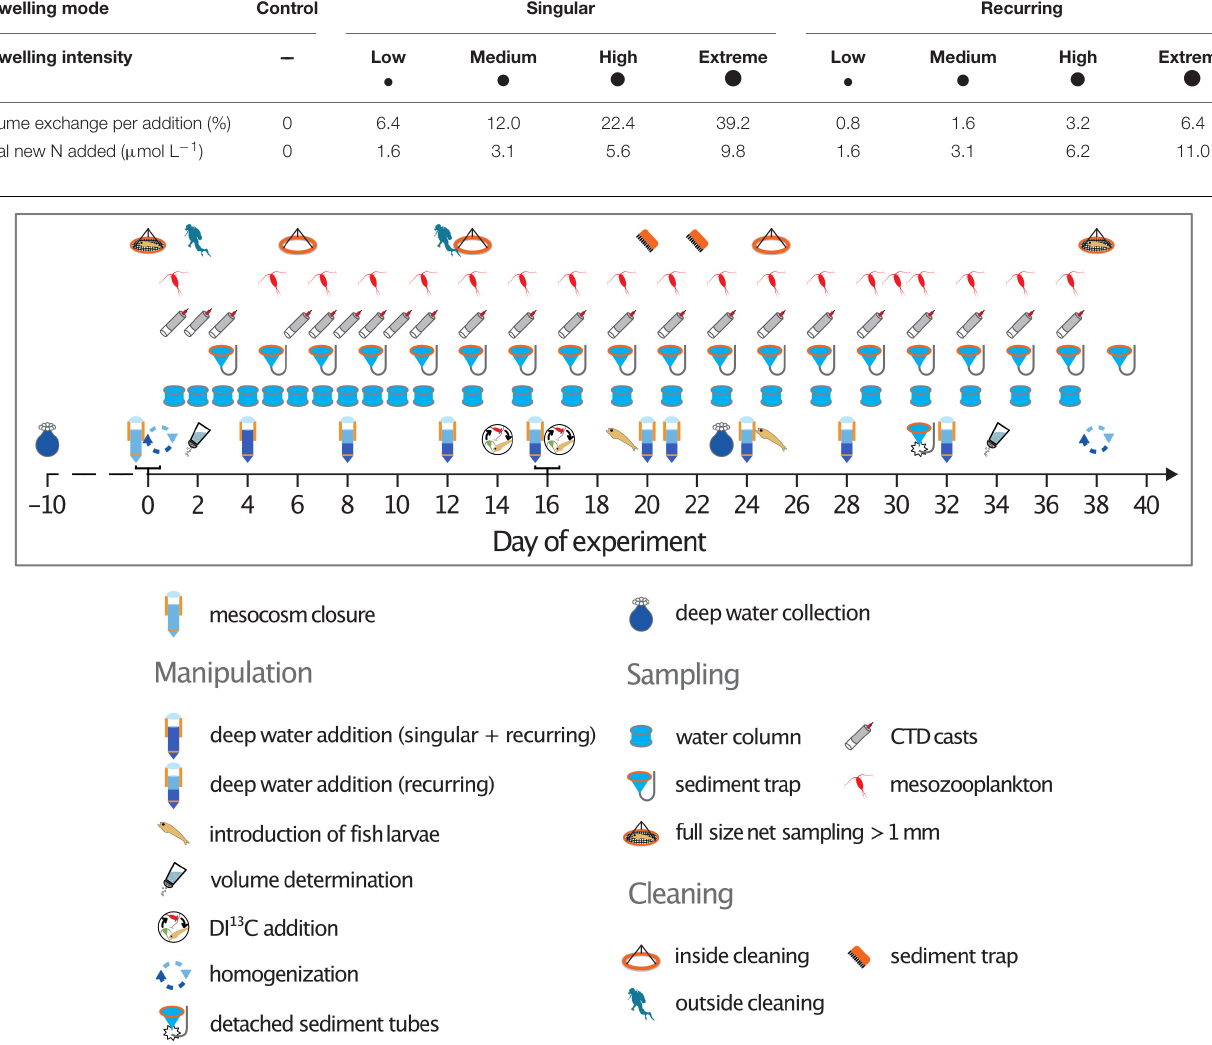
TABLE 1 | Treatment overview indicating different upwelling modes and intensities, mean net volume exchange of surface water with nutrient-rich deep water per addition and the total amount of new nitrogen that was added via the addition of deep water throughout the experiment. Upwelling mode